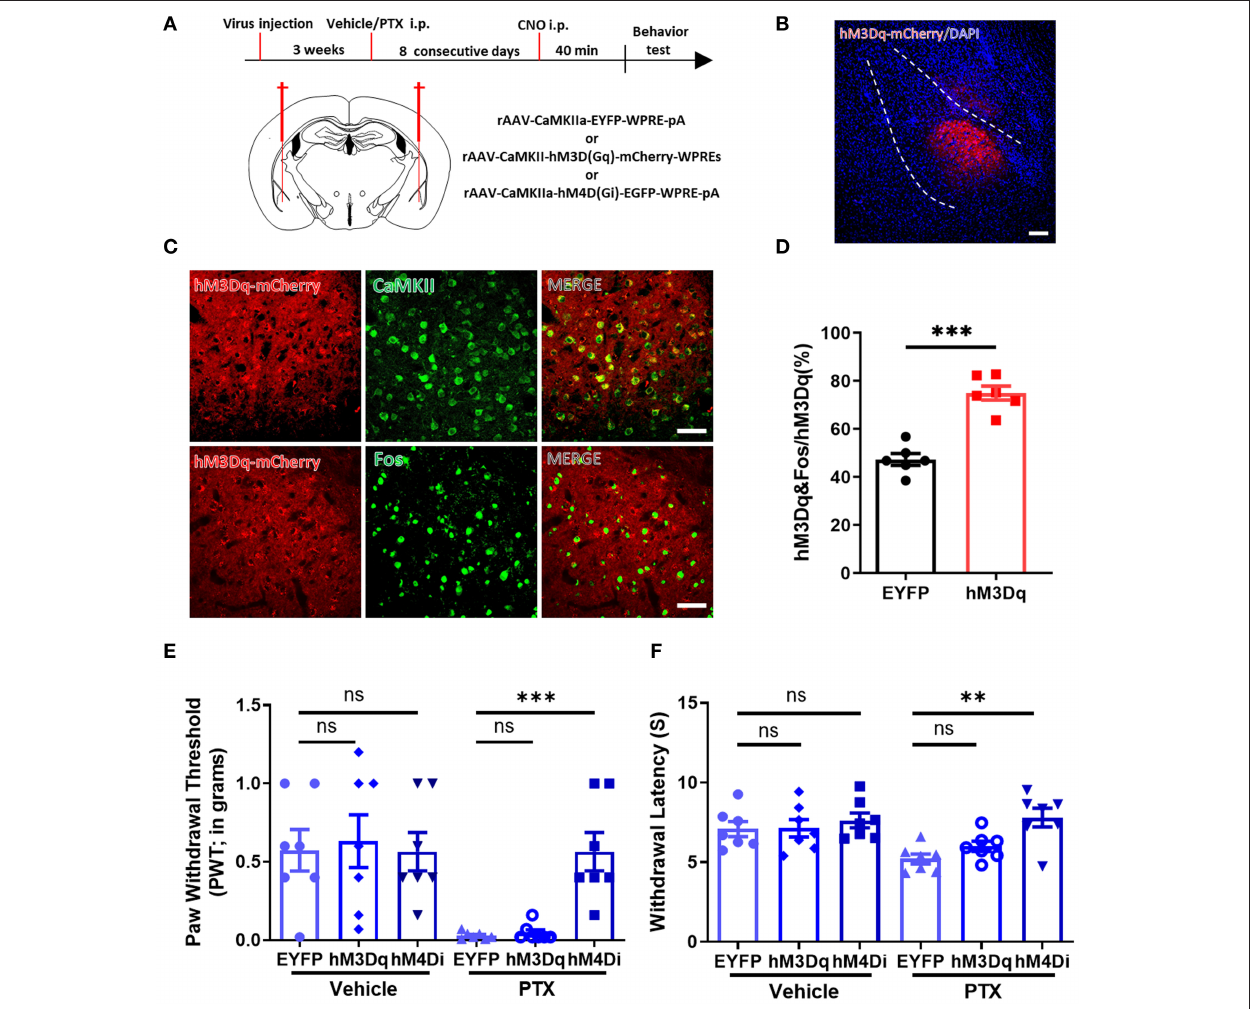
FIGURE 4 | Selectively inhibiting CaMKII neurons in the BLA relieves paclitaxel-induced pain. (A) Timeline of virus injection, Clozapine-N-oxide (CNO) administration, and experiments and the Schematic diagram of virus injection site. (B) Representative imaging of hM3Dq virus expression within CaMKII neurons in the BLA 3 weeks after viral injection. Scale bars = 100 µ m. (C) Representative imaging of hM3Dq virus expression within CaMKII neurons in the BLA 3 weeks after viral injection. Under high magnification co-labeled of hM3Dq-mCherry (red) and CaMKII (green), and co-labeled of hM3Dq-mCherry (red) and Fos (green). Scale bars = 50 µ m. (D) The percentage of the numbers of hM3Dq and Fos co-labeled neurons to hM3Dq labeled neurons in EYFP and hM3Dq. (E) Changes in PWT after activation or inhibition of CaMKII neurons. (F) Changes in PWL after activation or inhibition of CaMKII neurons. n = 6–7, ns, no significant, ** P < 0.01, *** P <